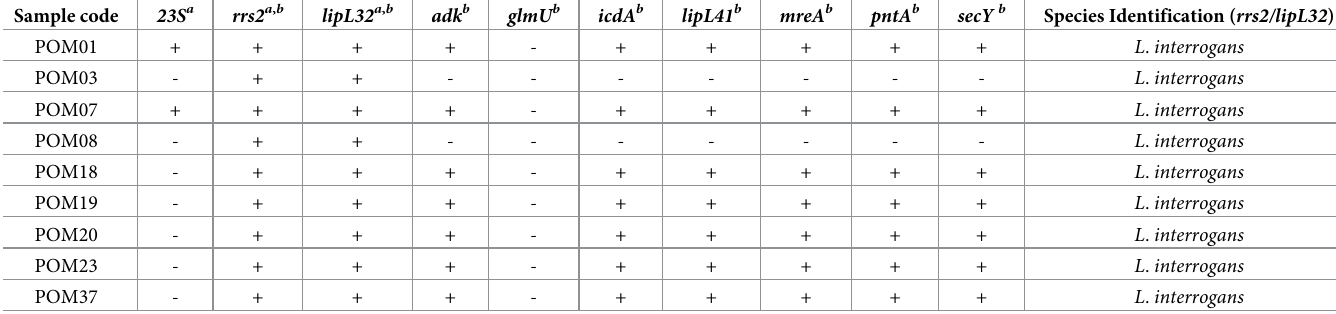
± indicates positive or negative amplification for each locus. a gene targets for PCR-based Leptospira detection. b loci included in Leptospira